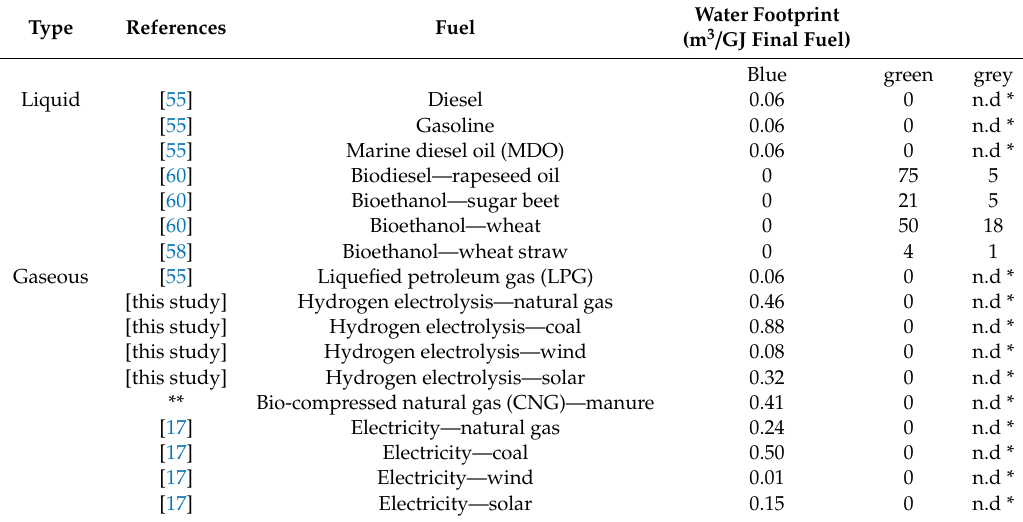
Table A3 gives the specific water footprints for fuels. Table A3. Specific water footprints for fuels. (Sources: Williams and Simons [55]; Mekonnen and Hoekstra [60]; Mathioudakis et al. [58]; this study; Mekonnen et al. [17]).